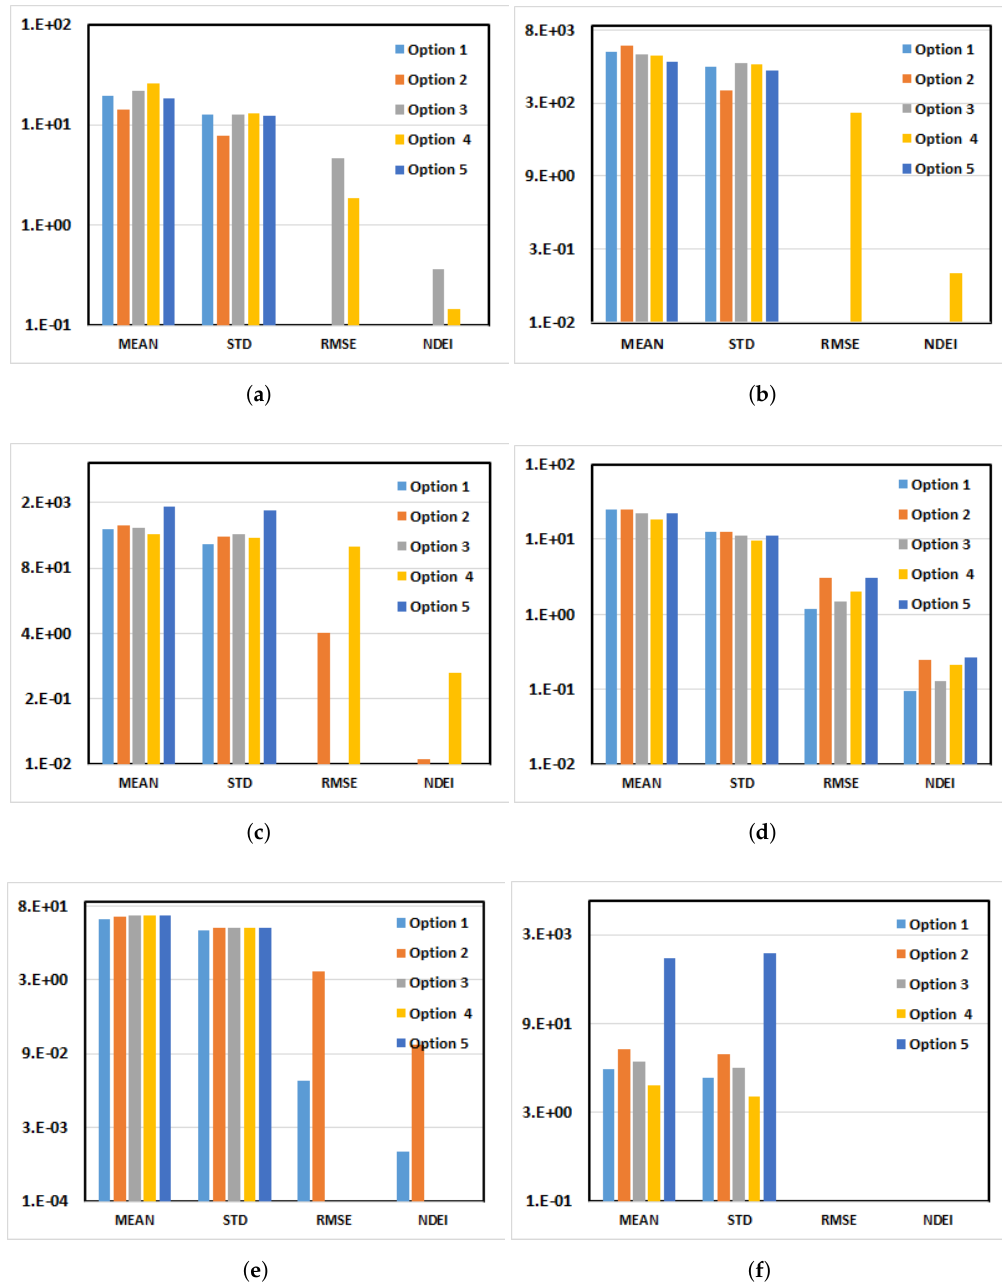
Figure A5. Statistical data plots of worldwide successful polymer injection EOR projects: ( a ) API; ( b ) depth; ( c ) permeability; ( d ) porosity; ( e ) saturation; and ( f )